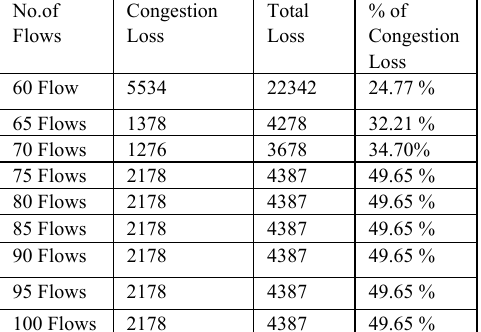
Table 5. Congestion loss ratio for ERCM